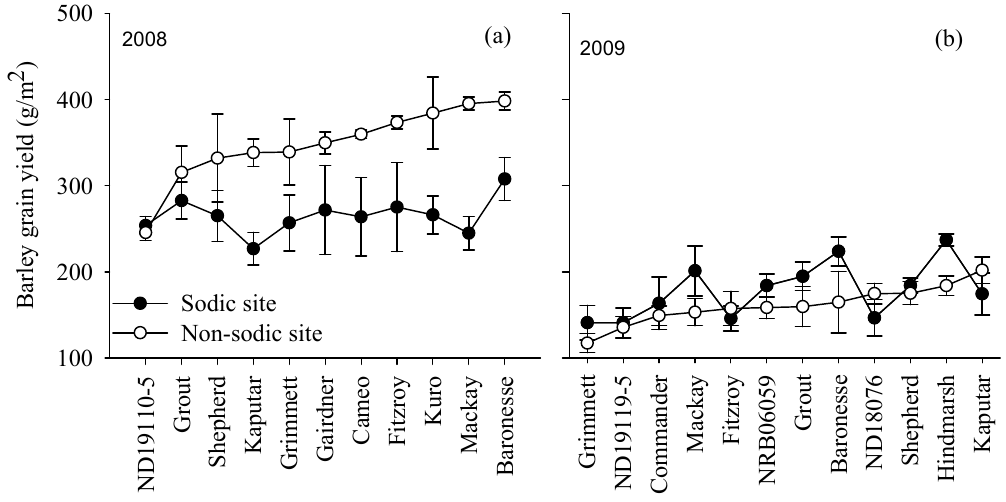
Figure 2. Grain yields ranking of barley genotypes grown on a sodic site and a non-sodic site Figure 1. Grain yields ranking of barley genotypes grown on a sodic site and a non ‐ sodic site in ( a ) in ( a ) 2008 and ( b ) 2009 near Goondiwindi in southern 2008 and ( b ) 2009 near Goondiwindi in southern Queensland.